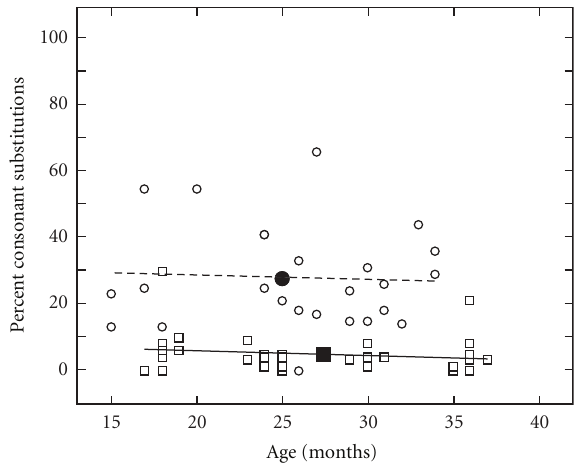
Figure 5: Percent of consonant substitutions determined from the PEEPS for the children with CLP (circles) and NC children (squares) across the ages of 18 to 36 months. The linear (CLP: dotted line) and curvilinear (NC: solid line) polynomials and means (filled symbols) are displayed for the